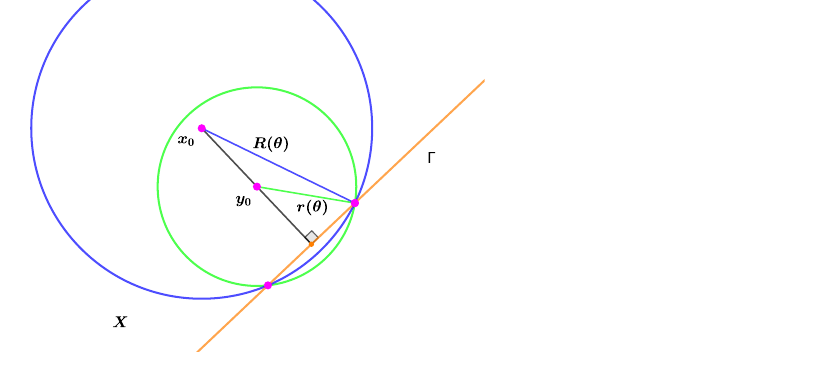
Figure 1. Game mechanism design in the half-plane X